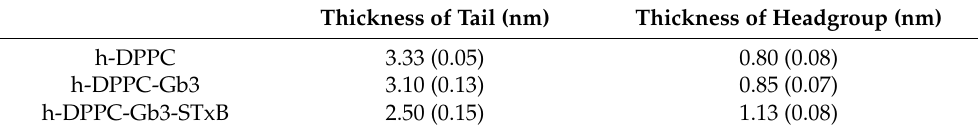
Table 2. The structural parameters obtained from small-angle neutron